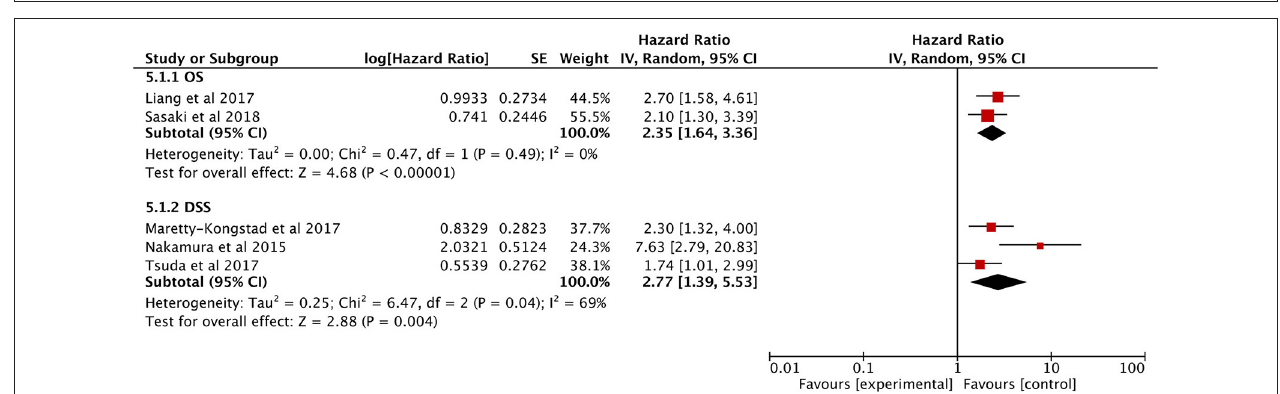
Frontiers in Oncology |